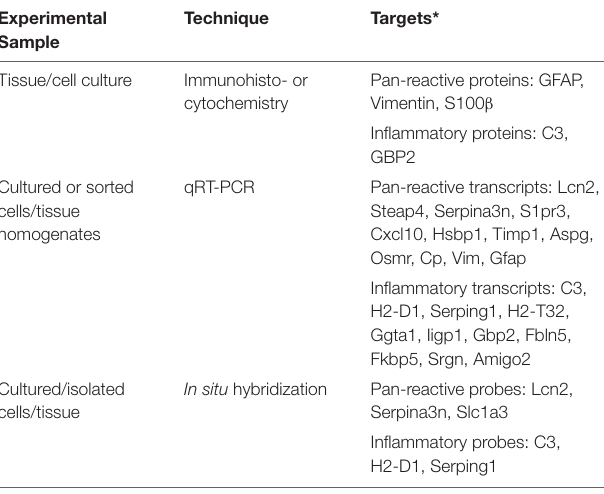
TABLE 1 | Commonly used techniques to identify inflammatory